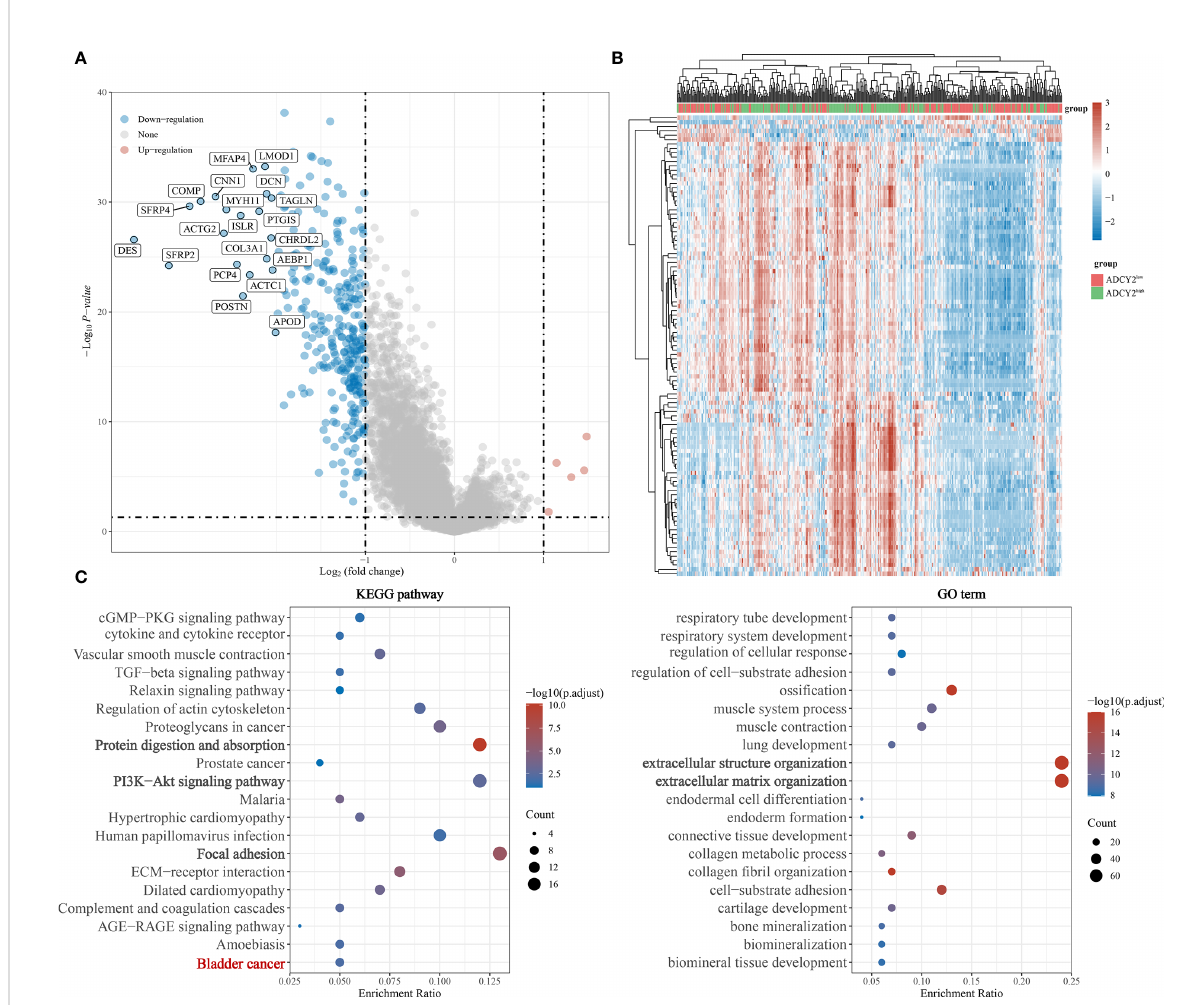
FIGURE 5 Functional enrichment annotations of ADCY2 expression in BCa. (A) A volcano plot of differentially expressed genes (DEGs), with down- regulated genes in blue and up-regulated genes in red. (B) Heat map of ADCY2 and DEGs. The low ADCY2 expression groups in red (at the top) and the high ADCY2 expression groups in green. Red and blue represent expression trends corresponding to up-regulated and down-regulated genes. (C) KEGG pathway and GO term functional enrichment